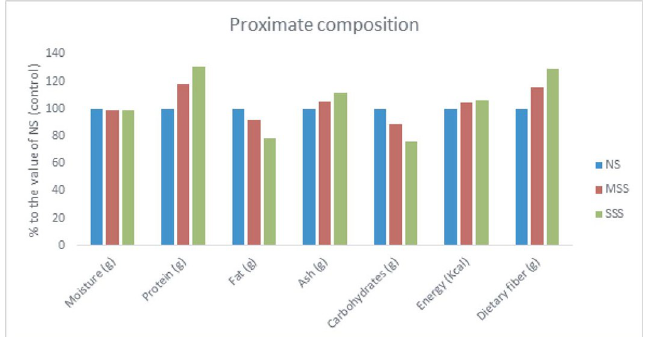
Fig 2. Changes of proximate composition (g 100 g -1 ) (% to the value of NS or control) in the leaves of A . tricolor accessions under three salinity stress levels. NS or control, no saline water; MSS, moderate salinity stress; and SSS, severe salinity